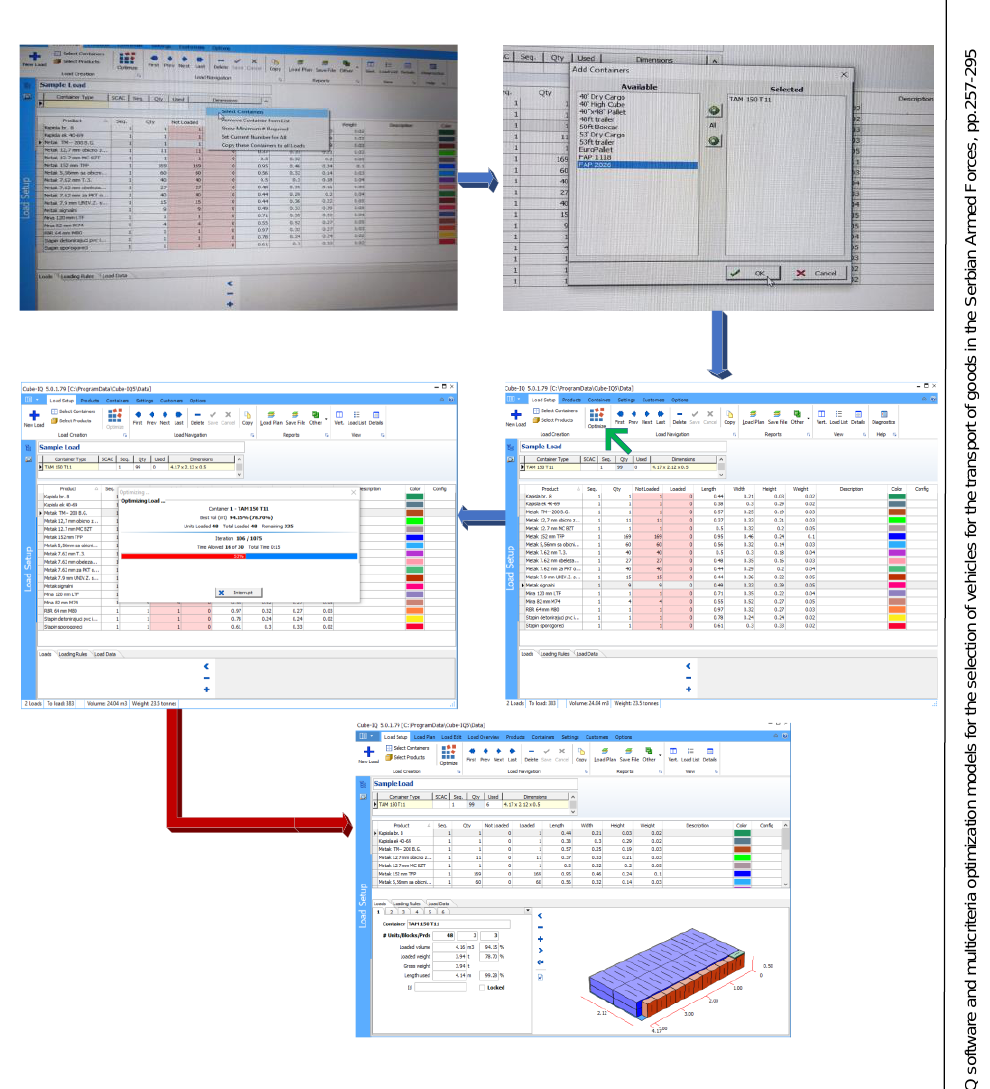
Figure 13 – Procedures for selecting a vehicle and packing it in Cube IQ Рис. 13 – Процедуры выбора транспортного средства и его погрузки в Cube IQ Слика 13 – Поступци приликом избора возила и његовог паковања у Cube